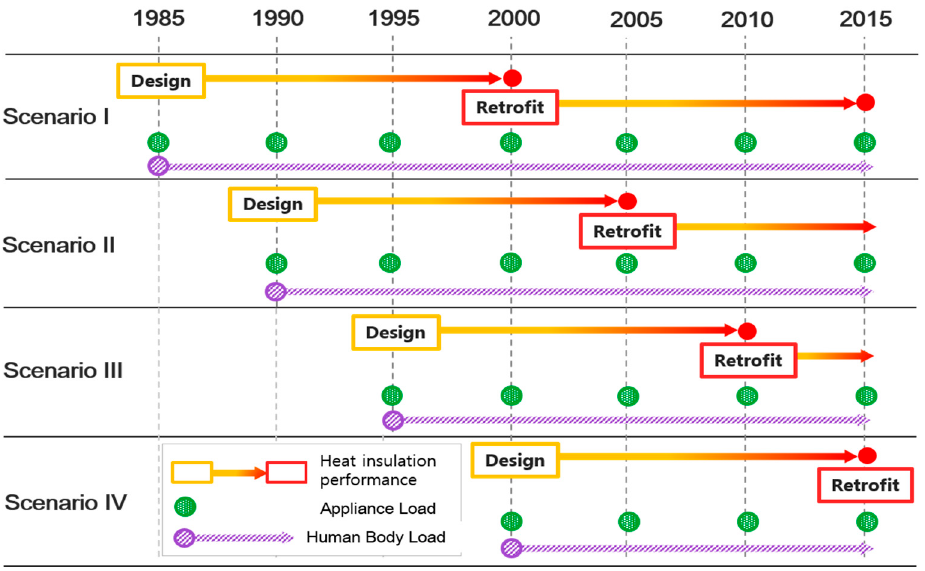
Figure 5. Retrofit and scenario overview.